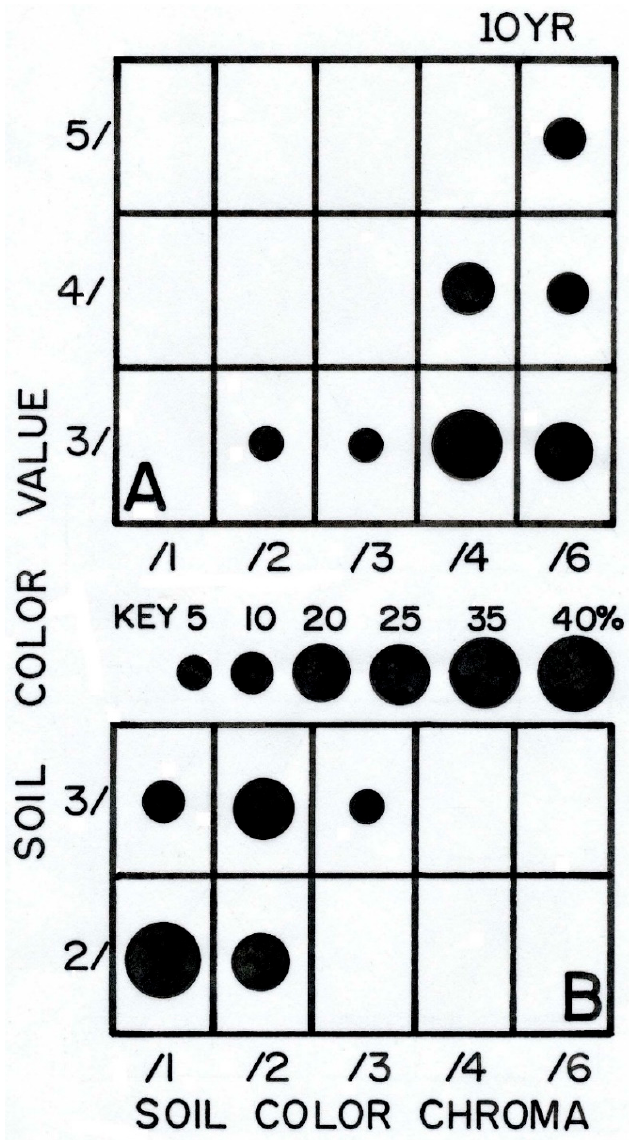
Figure 8. Color variation for dry soil samples. ( A ) Bare soils (control). ( B ) soils under LIs, below k¯upaoa canopy; each diagram includes 20 data points. All sample colors covered by the Munsell 10YR hue sheet [83]. Graphic key: Circles show percentages of samples associated with a color; the largest circle on each graph indicates modal —most common—color: a: 10YR 3/4 (dark yellowish brown), b: 10YR 2/1 (black).